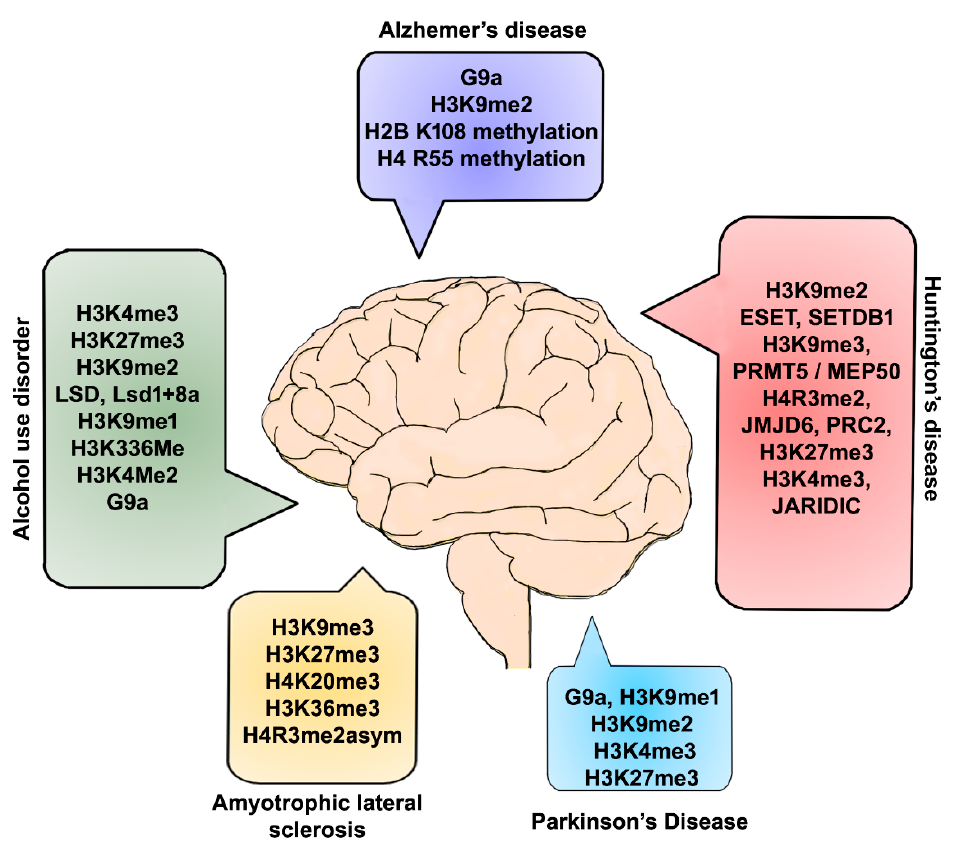
Figure 2. Graphical summary of histone methylation-specific epigenetic defects in ND disorders. Neurodegeneration-inducing conditions have been shown to affect DNA-associated histone methylation via specific KMTs and KDMs, followed by several changes in gene and protein expression that are important for cognitive and other ND-related brain pathologies.